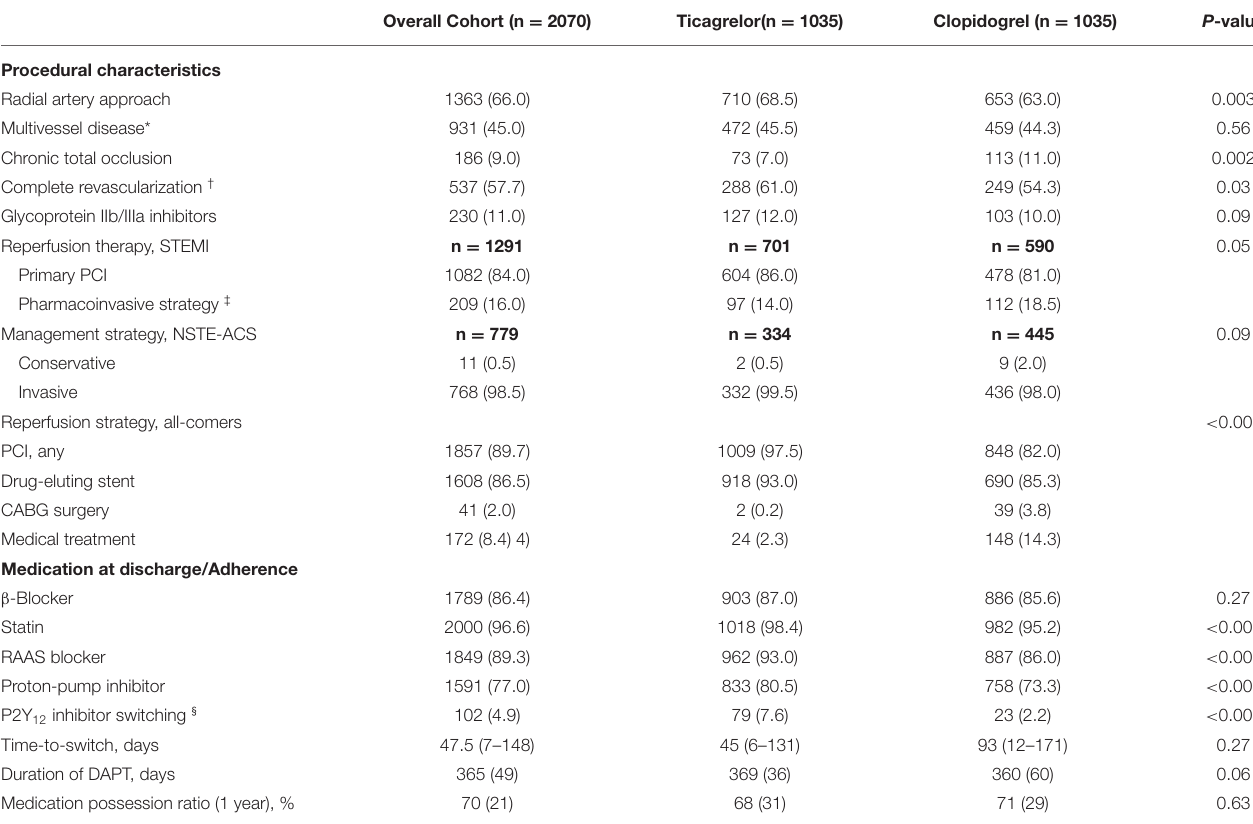
TABLE 2 | Procedural characteristics and medication at